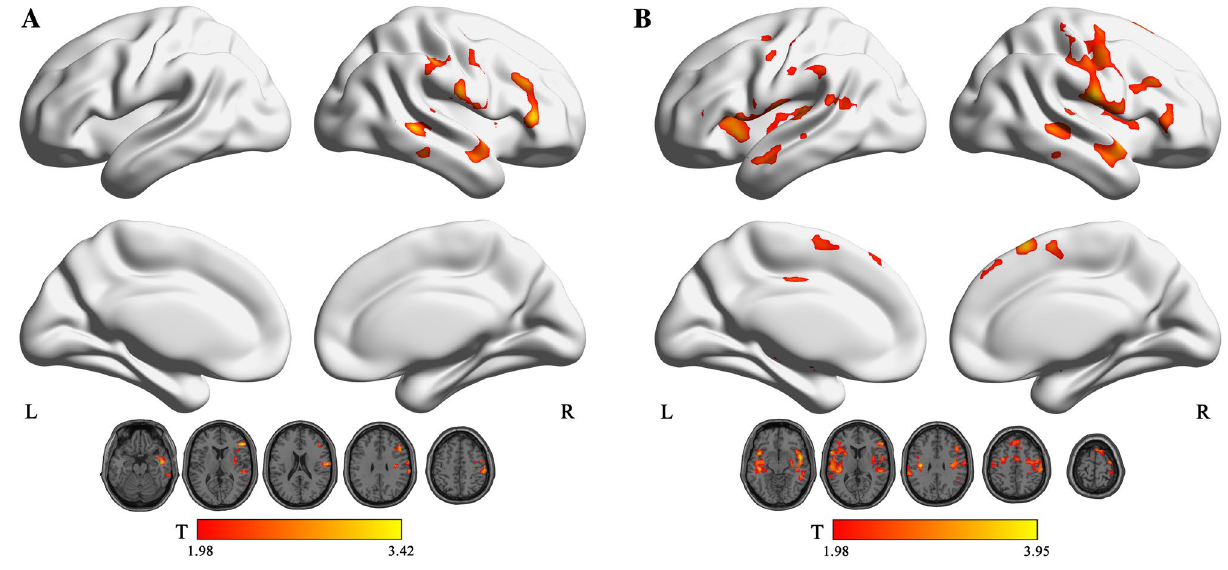
Figure 3. Brain regions with abnormal PerAF in typical low-frequency range and at slow-5 band in NE children. The results were corrected by GRF (voxel P < 0.05, cluster P < 0.05). More details of these regions were described in Table 4. ( A ) Right middle temporal gyrus with increased PerAF in typical low-frequency range (0.01–0.08 Hz). ( B ) Left insula, right temporal pole: middle temporal gyrus with increased PerAF in slow-5 band (0.01–0.027 Hz).